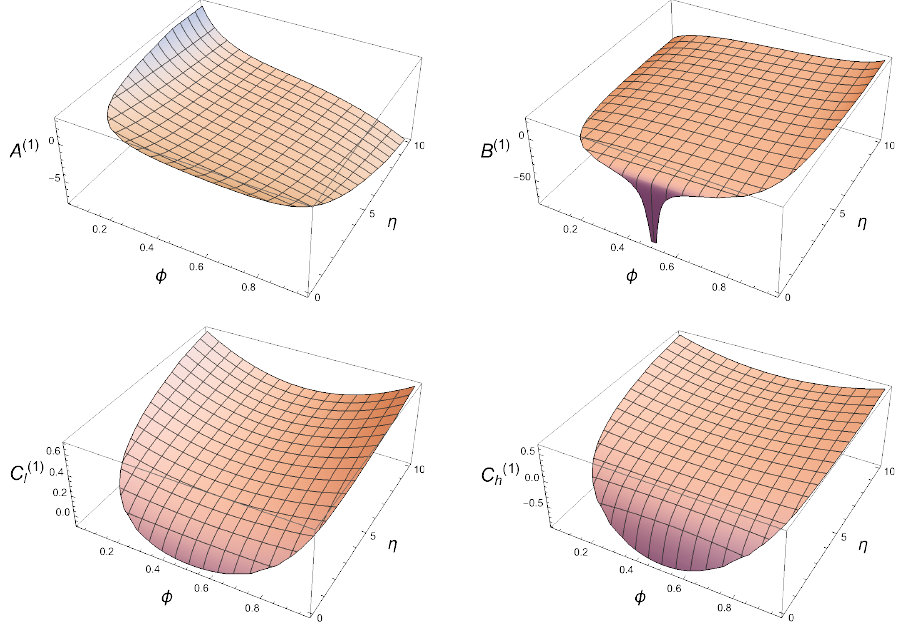
Figure 11 . Three-dimensional plots of the coefficients (finite part) appearing in the decomposition of the renormalised one-loop amplitude in eq.